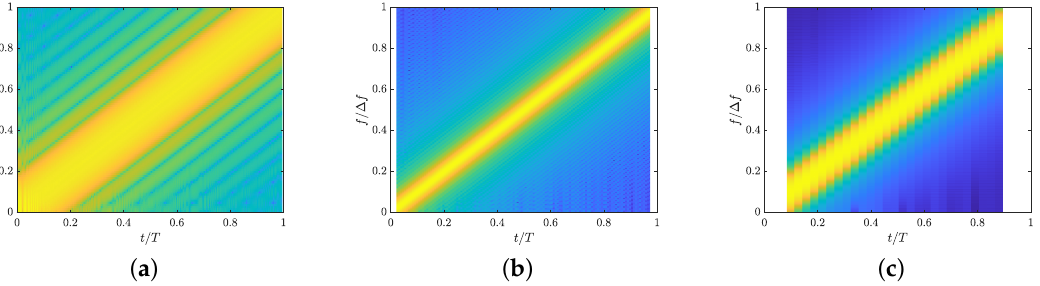
Figure 3. Spectrograms calculated for different window lengths that are ( a ) too short; ( b ) optimal; ( c ) too